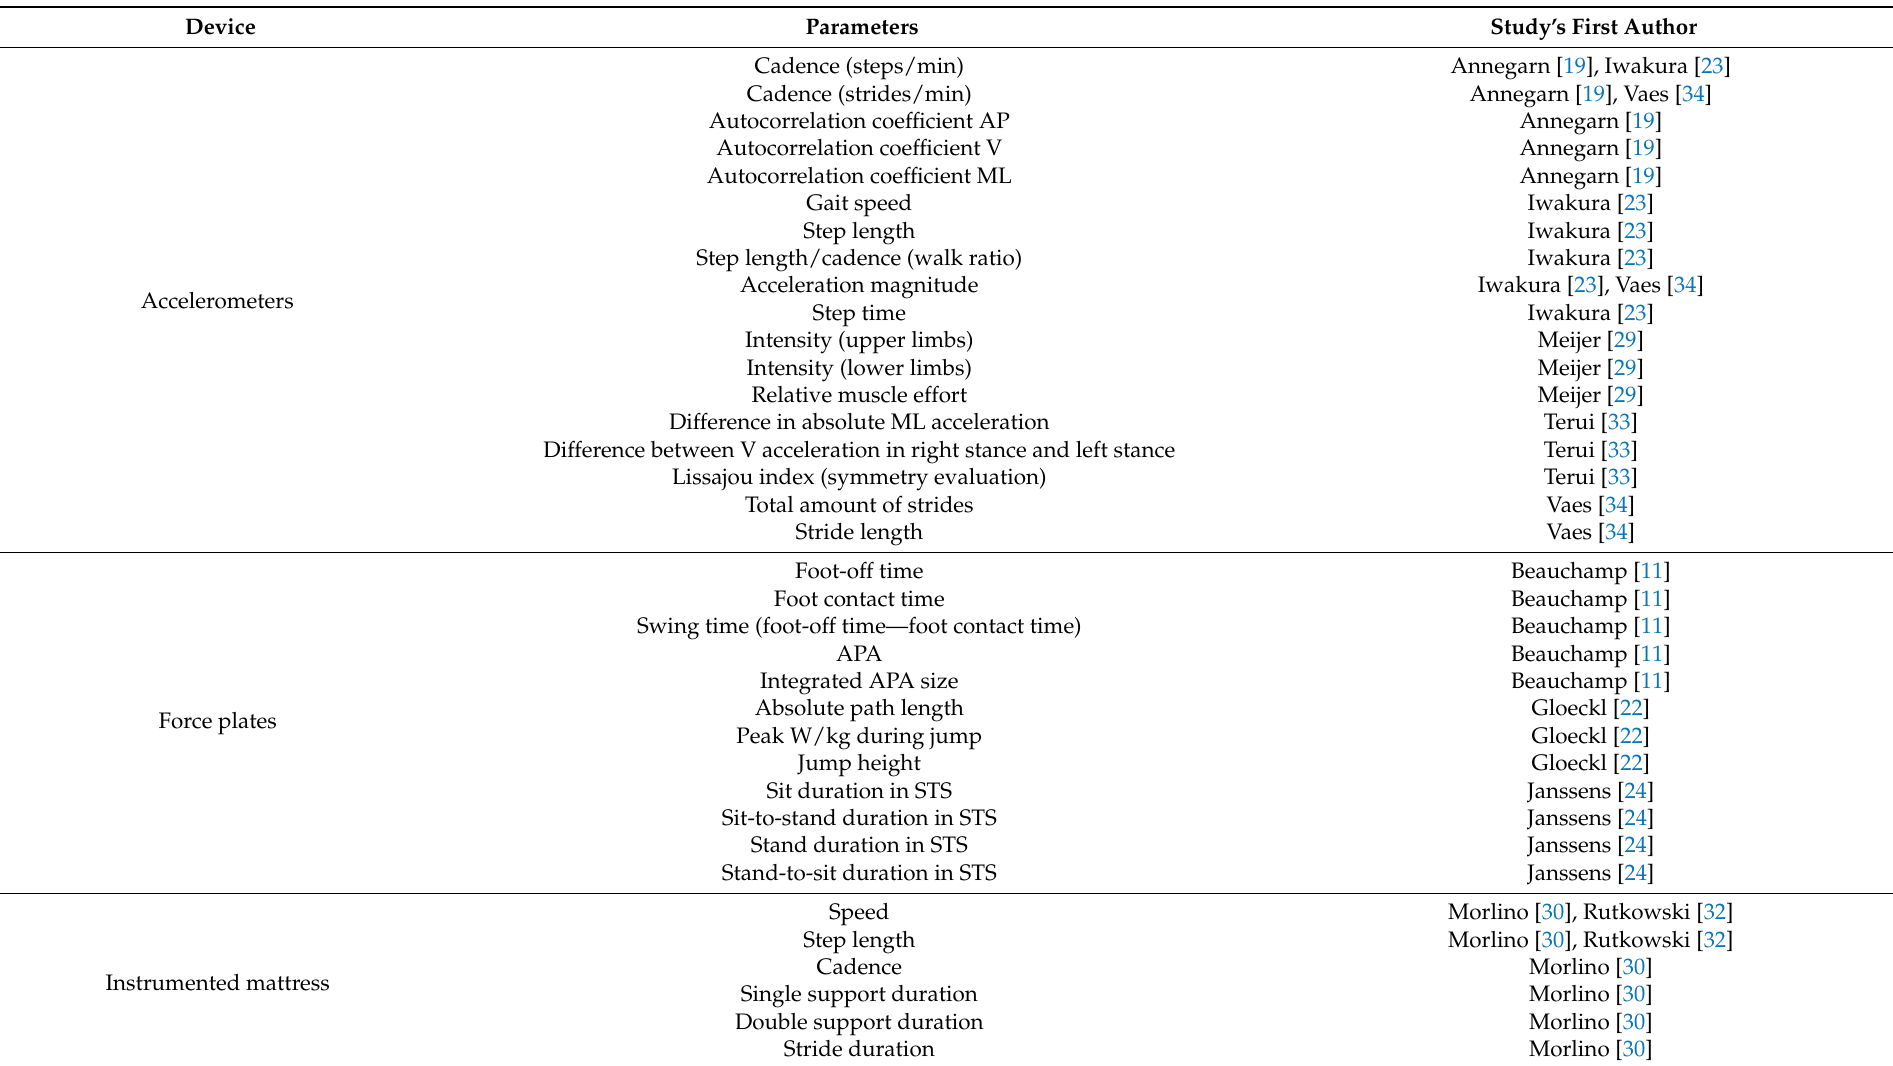
Table 4. Parameters estimated from different